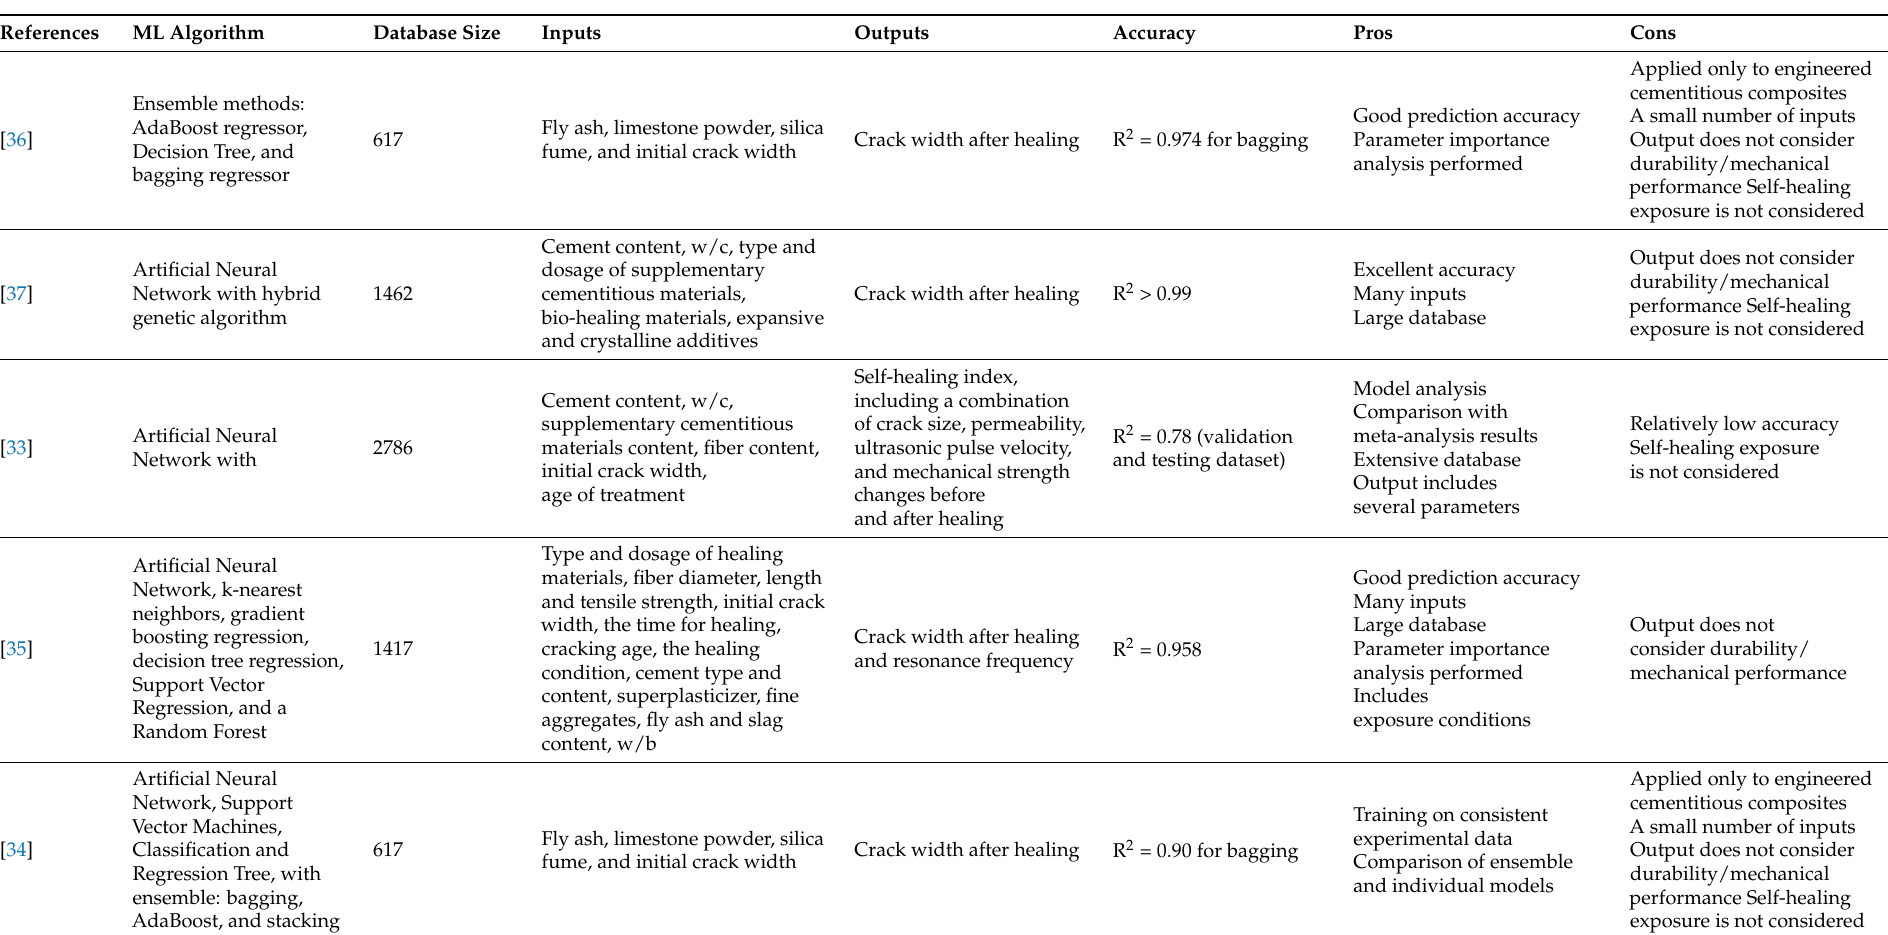
Table 1. Examples of ML modeling of autogenous